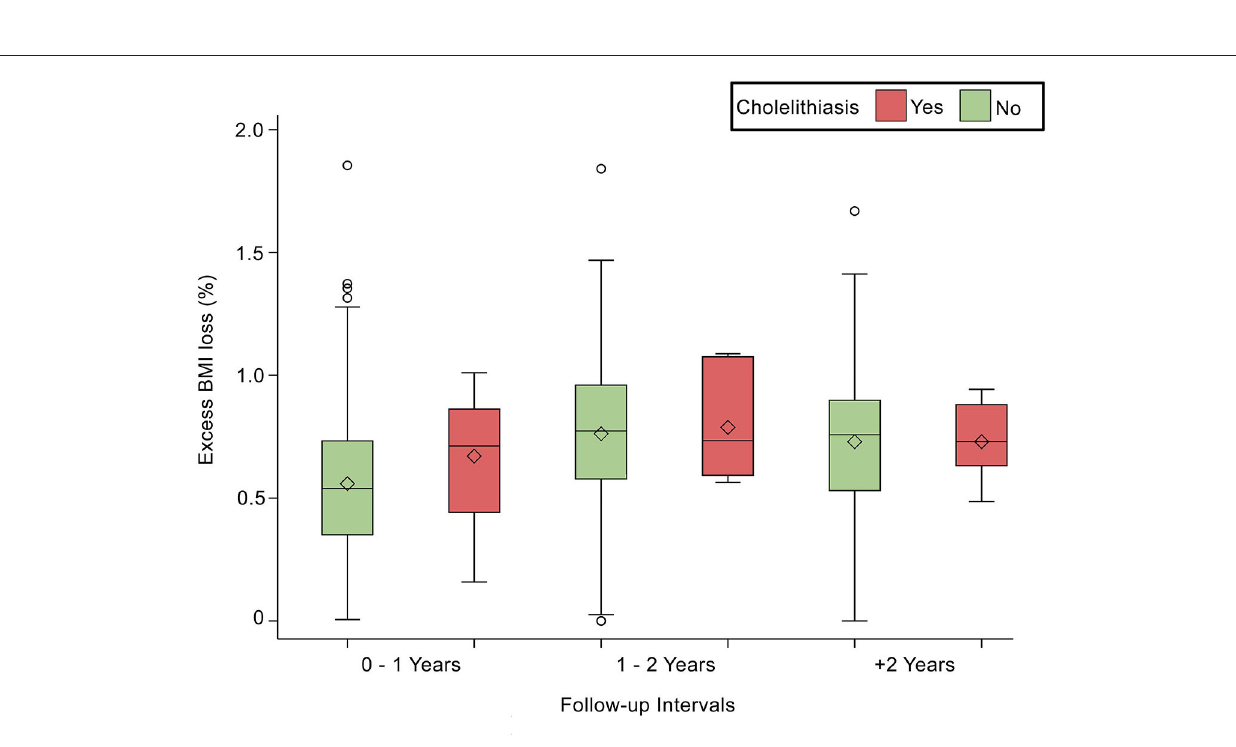
Frontiers in Surgery |